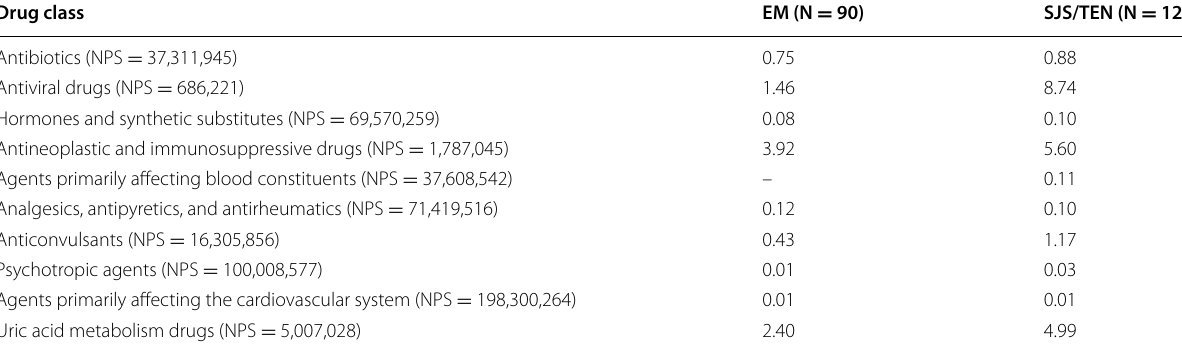
Table 4 Number of hospitalisations with an associated diagnosis of erythema multiforme (EM) and Stevens–Johnson syndrome/toxic epidermal necrolysis (SJS/TEN) per million sold packages of drug classes involved in adverse